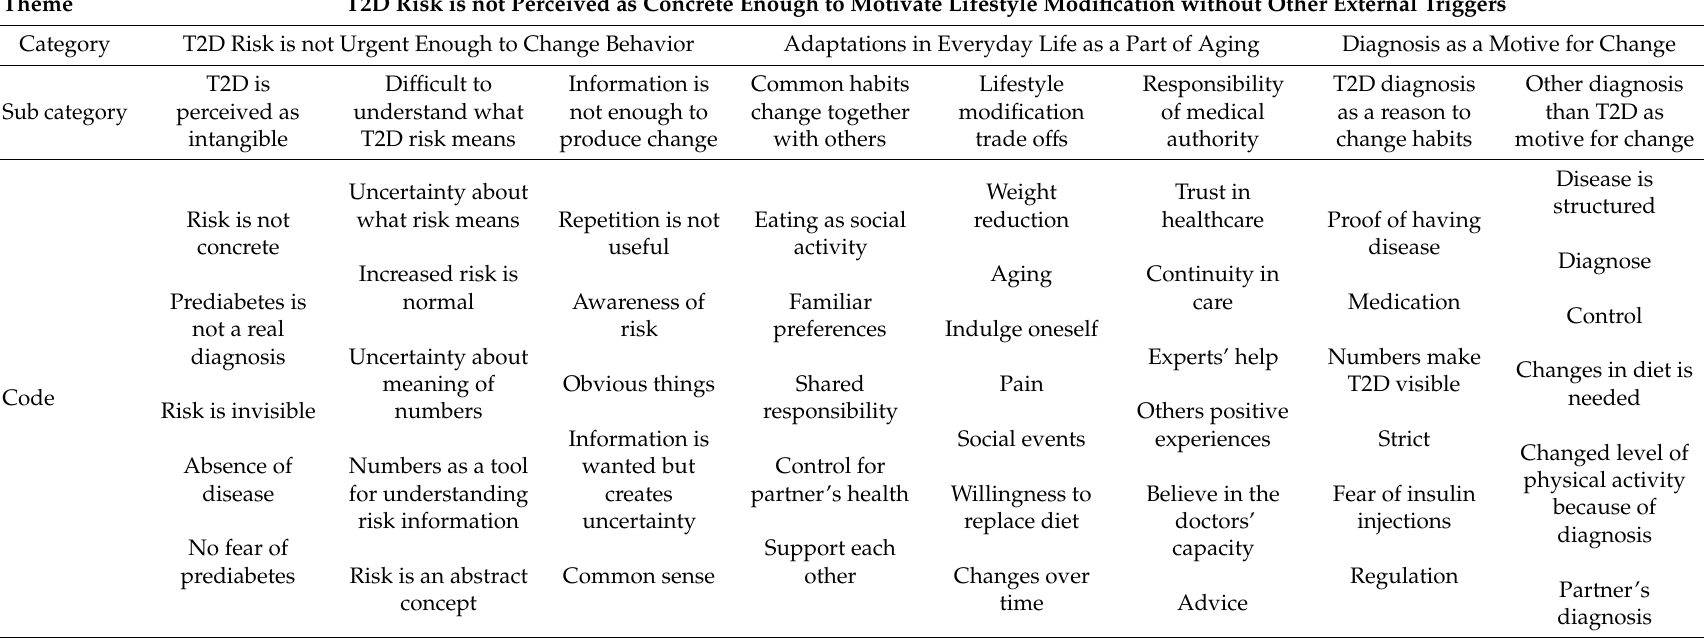
Table 2. Overview of the results